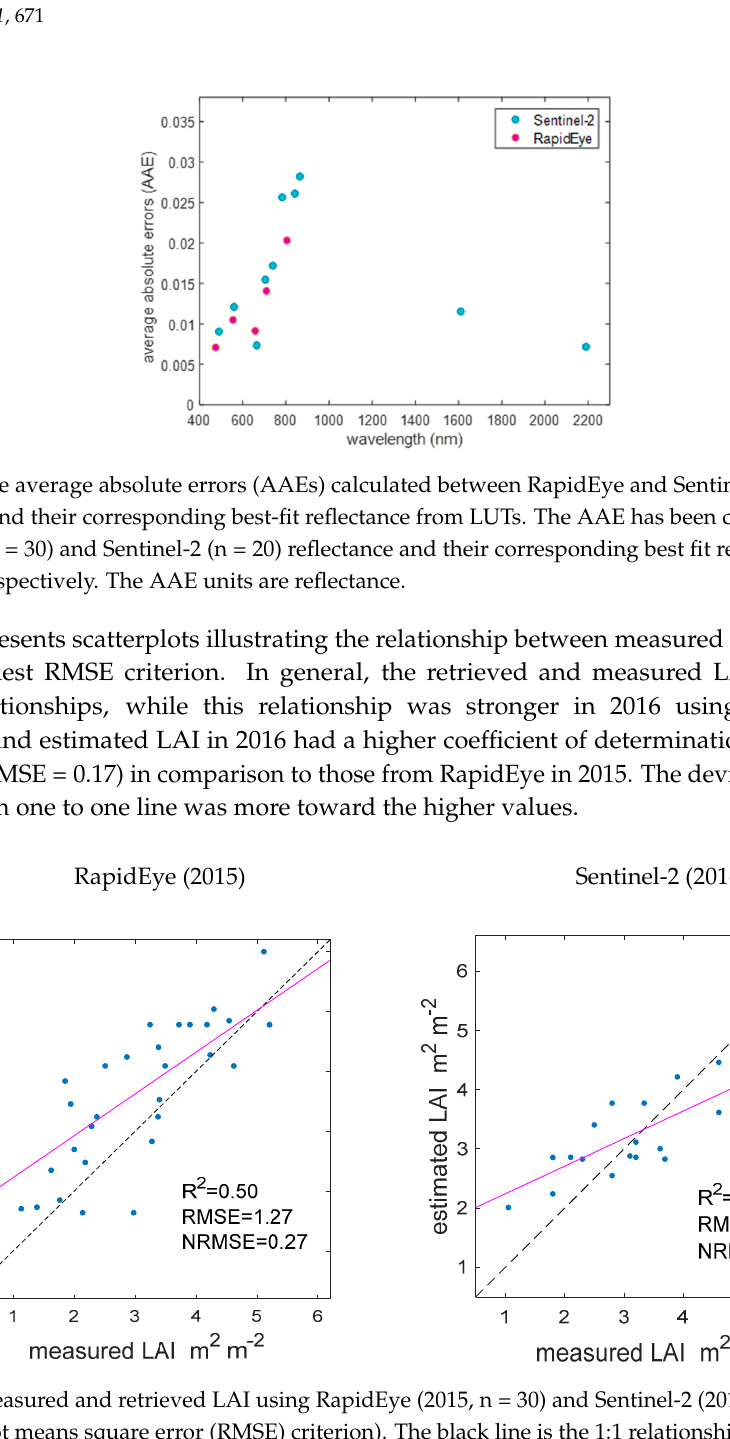
Figure 7. Measured and retrieved LAI using RapidEye (2015, n = 30) and Sentinel-2 (2016, n = 20) data (smallest root means square error (RMSE) criterion). The black line is the 1:1 relationship and the pink line presents the relationship between the retrieved and measured LAI.